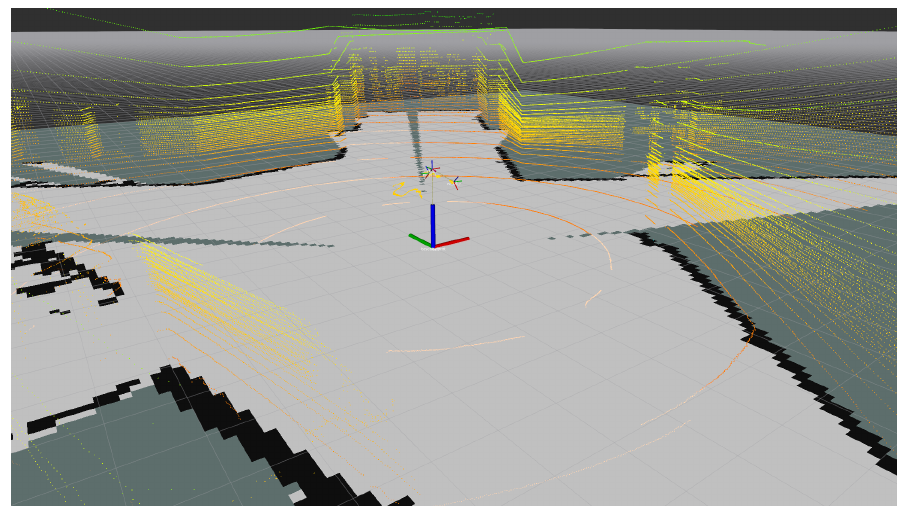
Figure 4. Local occupancy grid map generation from light detection and ranging (LiDAR)